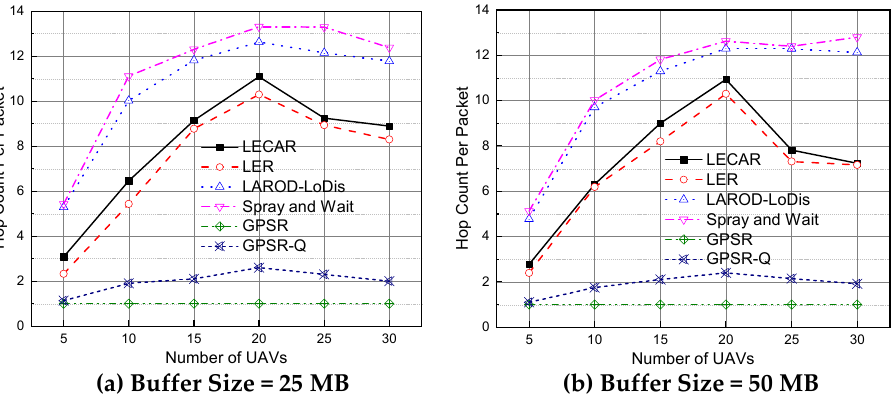
Figure 12. Performance comparison of the routing protocols regarding the hop count per packet when the buffer size is ( a ) 25 MB and ( b ) 50 MB.